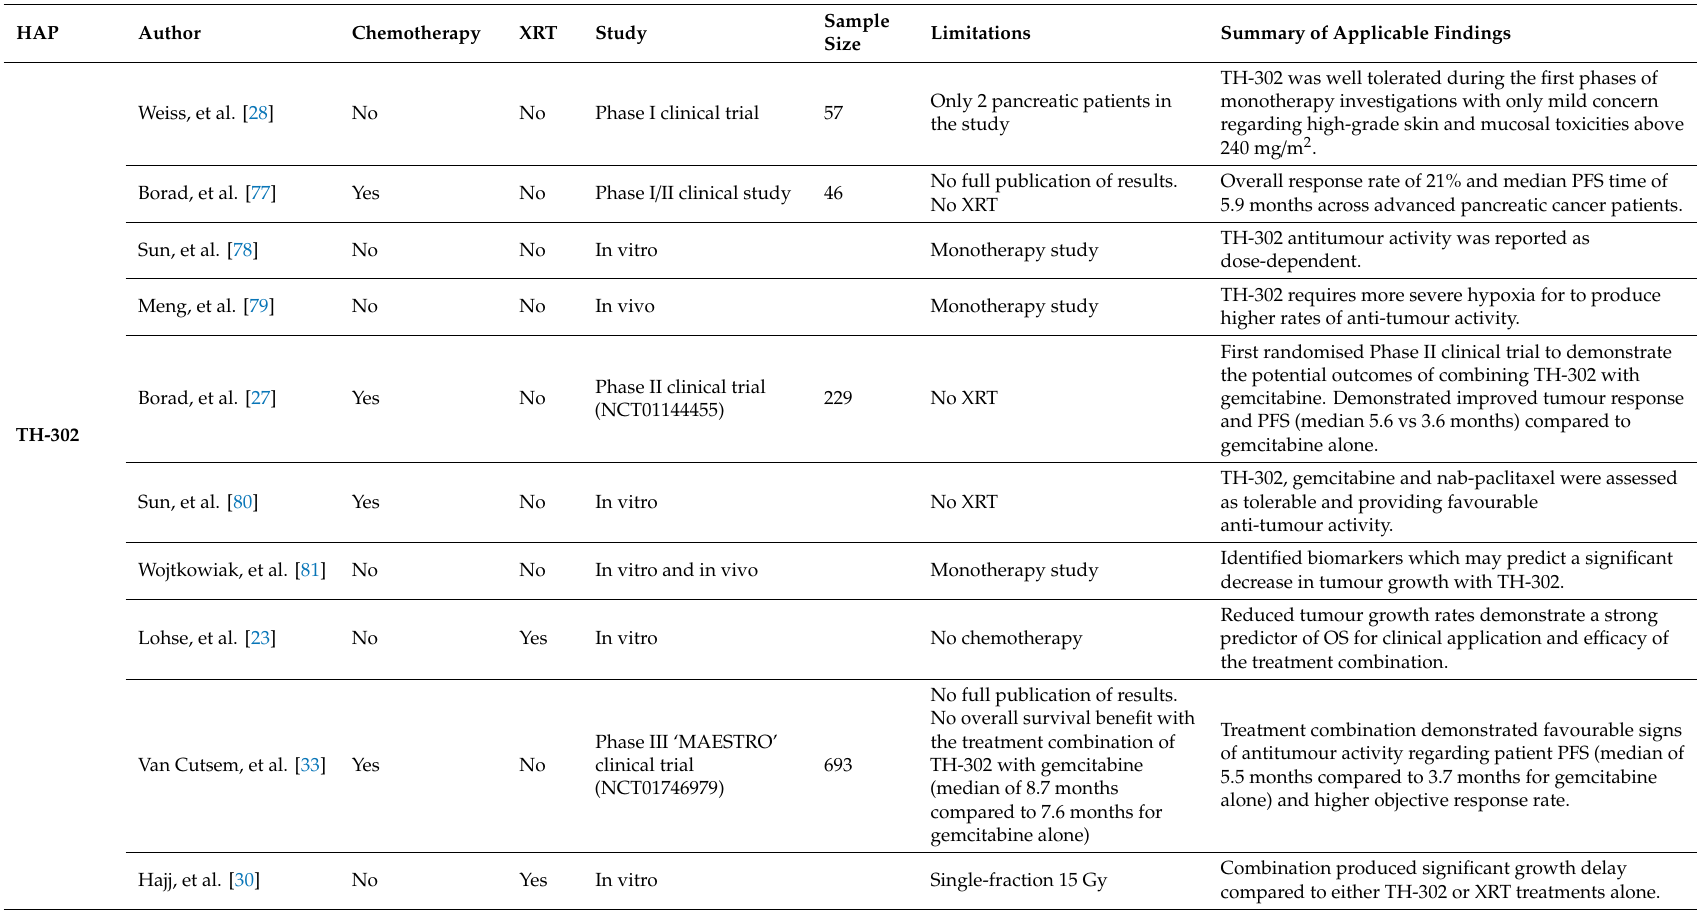
Table 1. Overview of studies investigating hypoxia-activated drugs (pHAPs) in pancreatic cancer